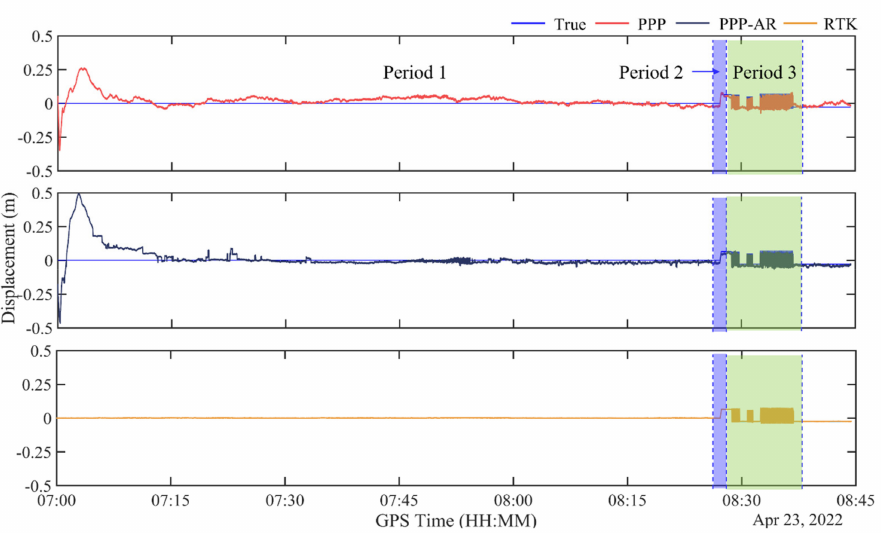
Figure 2. Displacement time series computed from the GCER observations and (top) PPP, (middle) PPP-AR, and (bottom) RTK